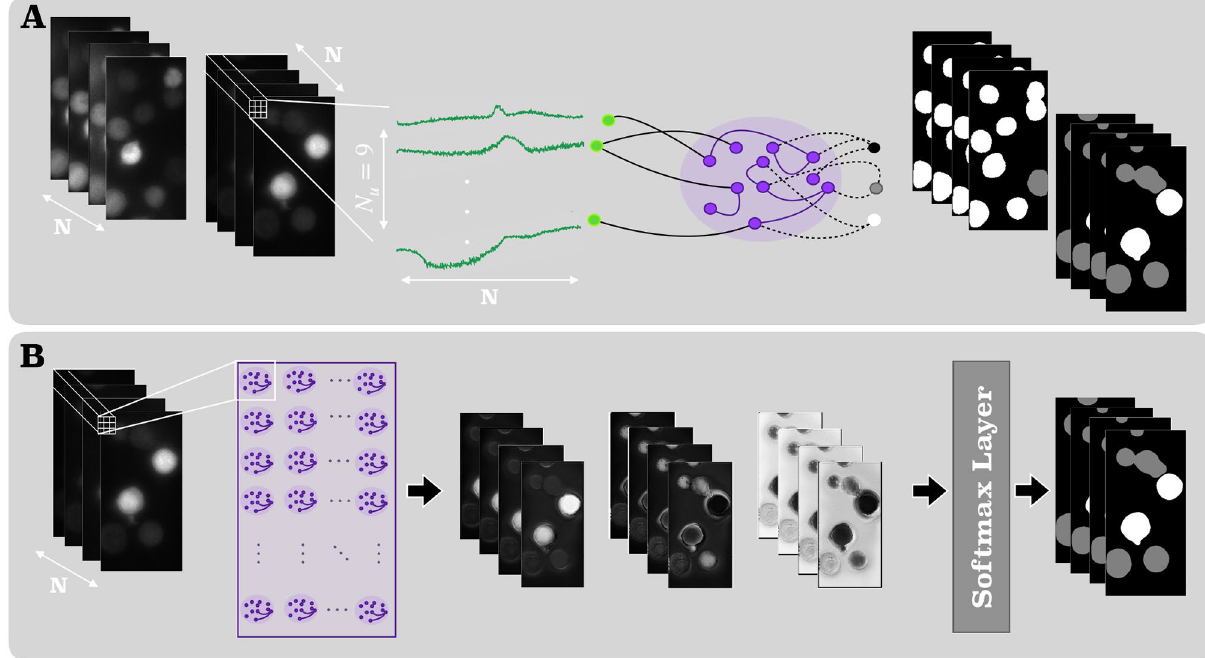
Figure 2. Illustration of the distributed RC structure for segmentation/classification (task 3) using encoding scheme 2. ( A ) Schematic of a single reservoir computing model trained on multitudes of N u = 9 univariate time-series recorded at the sites of randomly sampled adjacent pixels. The three outputs are associated with ternary output classes. ( B ) Illustration of the system functioning during model inference [Graphics created with MATLAB and the Image Processing Toolbox Release 2019b, The MathWorks, Inc. (http:// mathw orks. com/ produ cts/ image.